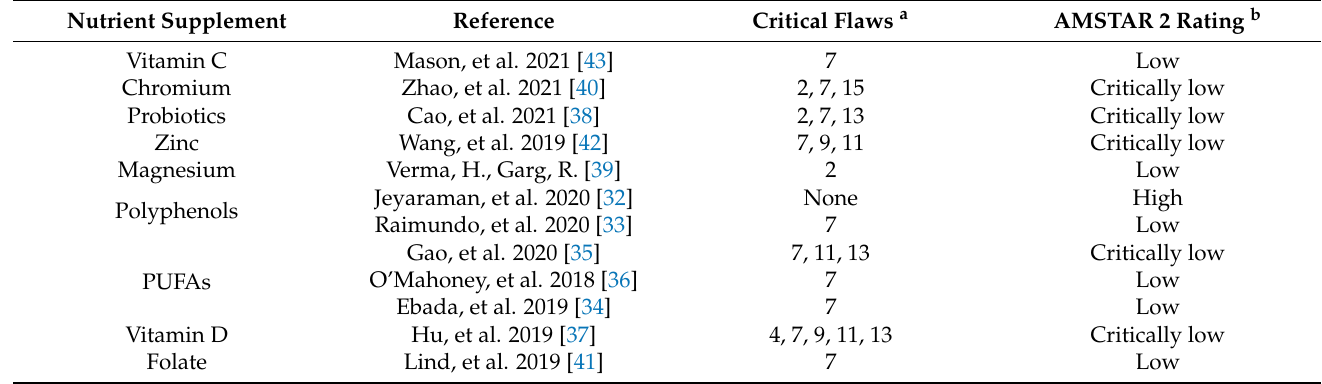
Table 2. AMSTAR 2 rating of included